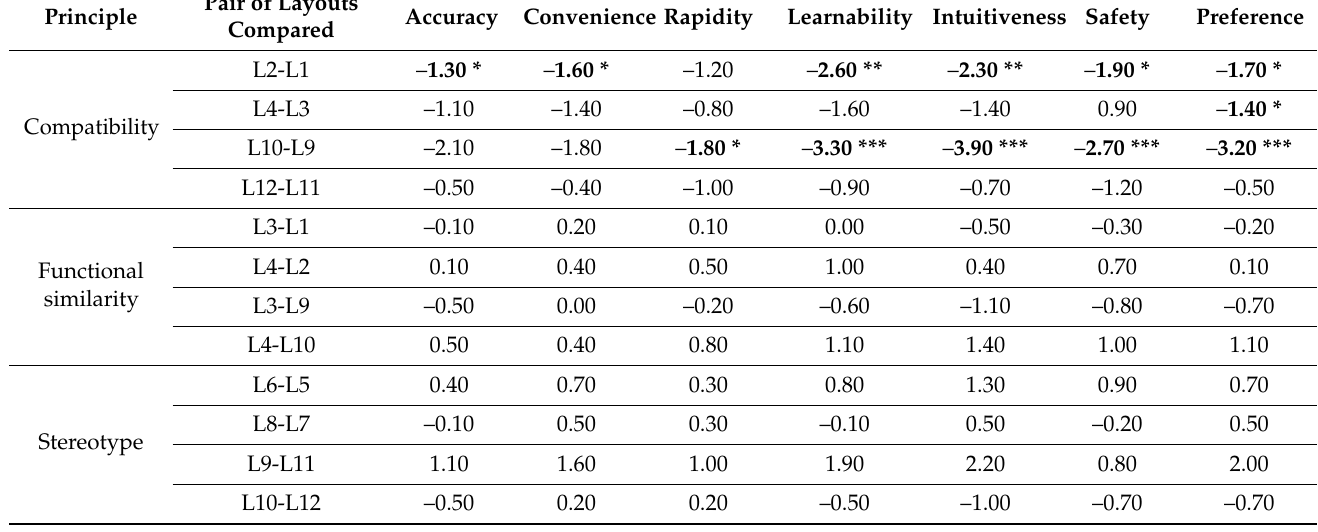
Table 9. Evaluation results for experienced driver group: mean differences between layouts to which ergonomic principles were applied and layouts to which they were not